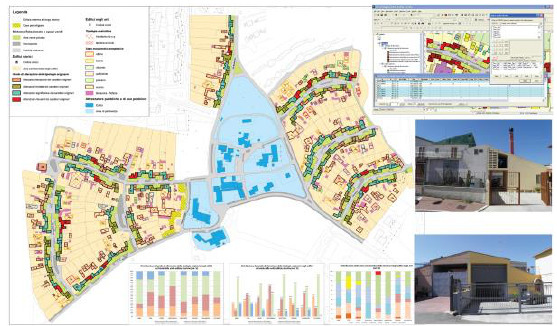
Figure 4. Definition of specific thematic information